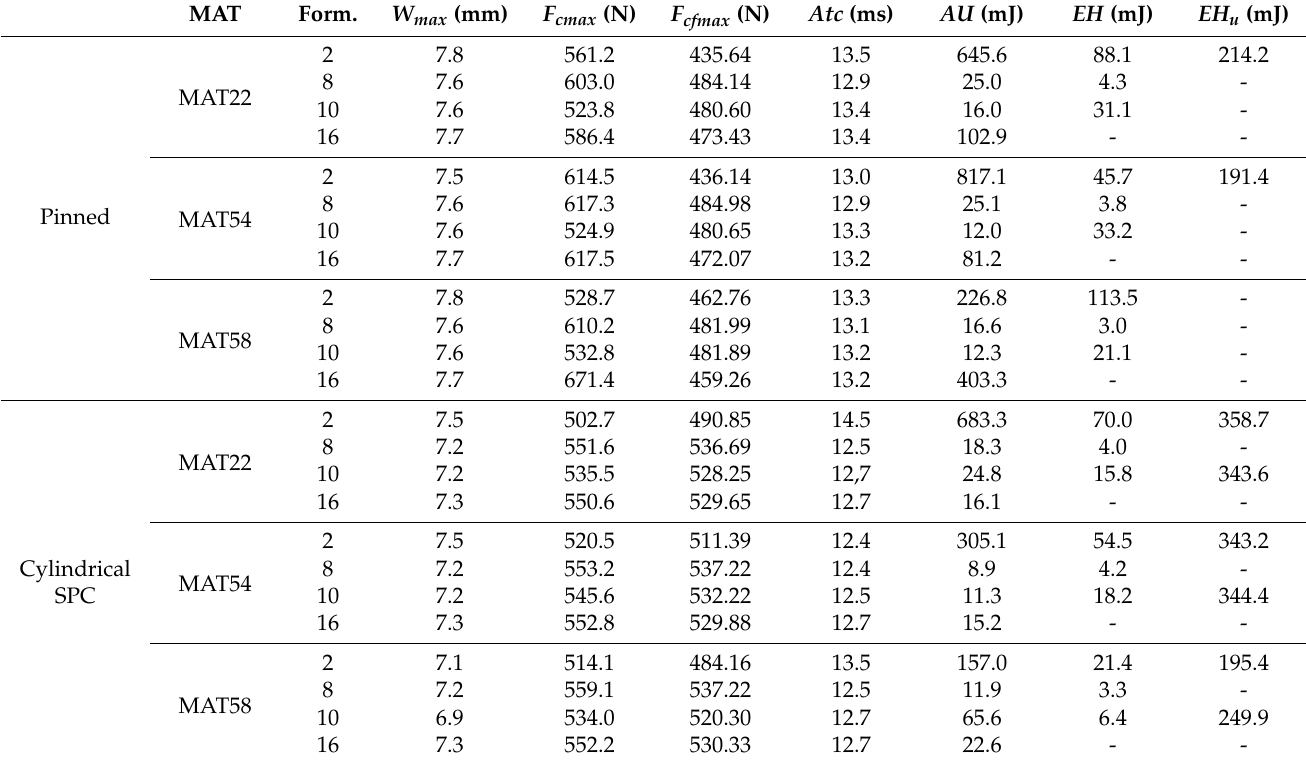
Table 5. Parametric analysis for sample A.